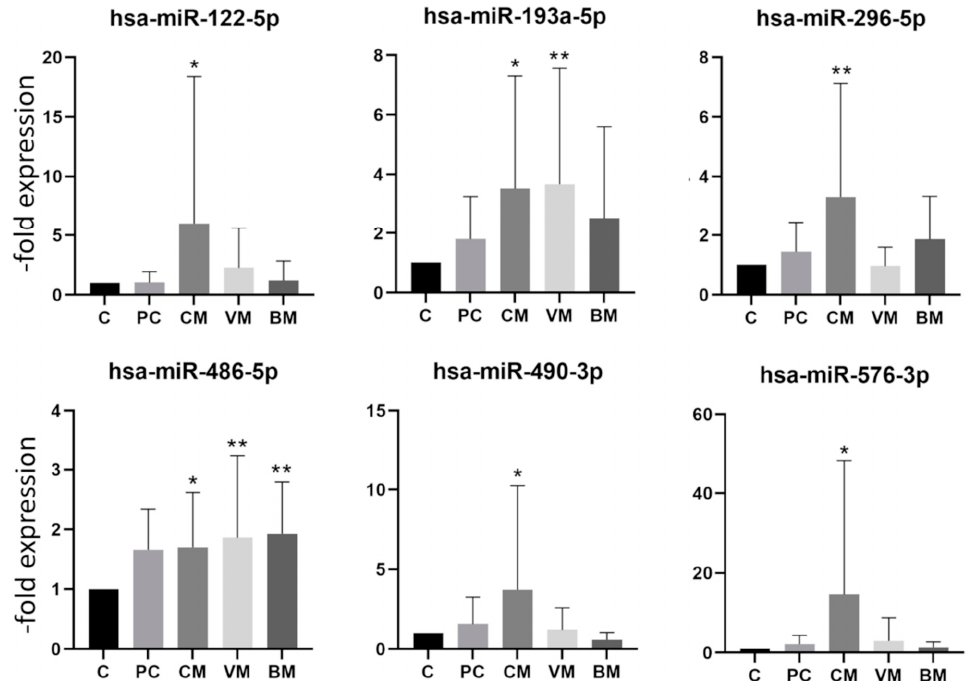
Figure 2. Expression levels of upregulated miRNA in exosomes from healthy controls and breast cancer patients with primary cancer (PC) and cerebral (CM), visceral (VC), or bone (BM) metastases. Data are presented as mean values of fold expression over the control group with standard deviations, * p < 0.05, ** p < 0.01. Figure 3 depicts the eight miRs with a significantly downregulated expression at least in one of the groups. Again, there was no miR, which was significantly downregulated in all groups. The